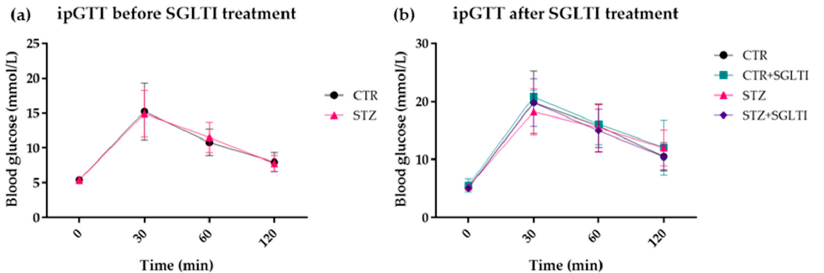
Figure 4. Results of the intraperitoneal glucose tolerance tests (ipGTT) performed before ( a ) and after phloridzin treatment. Data presented as mean ± SD and analysed by 2-way repeated measures ANOVA with Sidak ( a ) and Bonferroni’s ( b ) multiple comparisons test between groups. SGLTI— sodium–glucose co-transporter inhibitor; CTR—control group; STZ—streptozotocin-treated group; CTR+SGLTI—control group treated with phloridzin; STZ+SGLTI—streptozotocin-treated group treated with phloridzin.